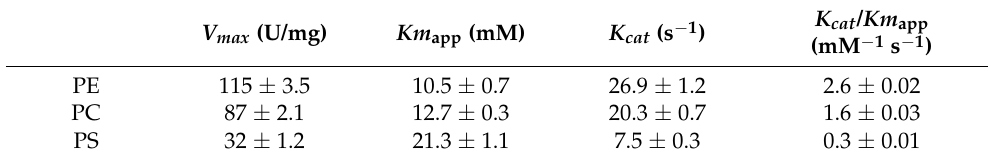
Table 2. Apparent kinetic parameters of DrPLA 2 -V.